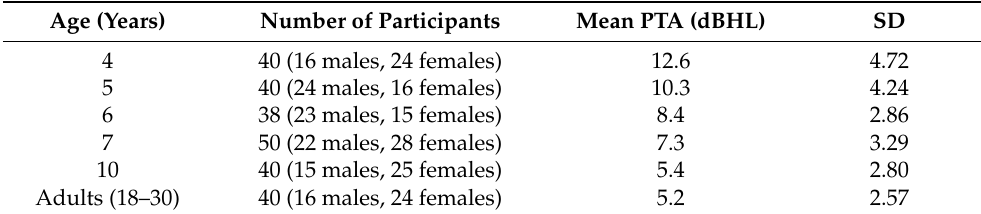
Table 1. Number of participants for every age group and Mean